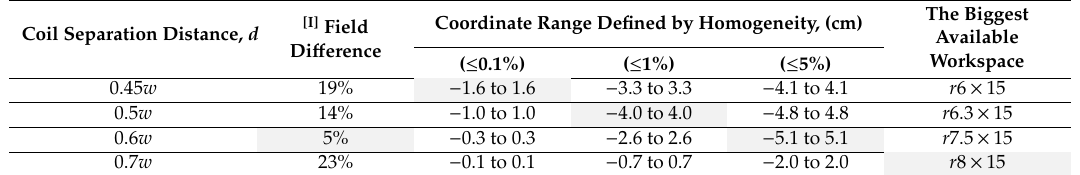
Figure A1. Field distribution of the 45 ◦ -y-bent coil. Field strength of four values of the coil separation distance, d , is plotted against the y-coordinate. Red circle displays a r 6 × 15 cm 3 cylindrical workspace, hidden-line box defines a boundary equal to diameter of the workspace over which the field is distributed. Highlighted areas indicate the best result when comparing to the Others. Table A1. Coil separation distance and field distribution of the y -bent coils.